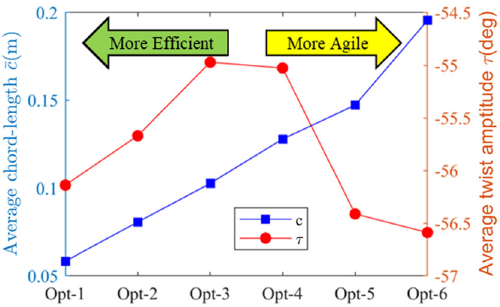
Figure 24. Average relative blade width and average twist amplitude of different optimal FPPs.